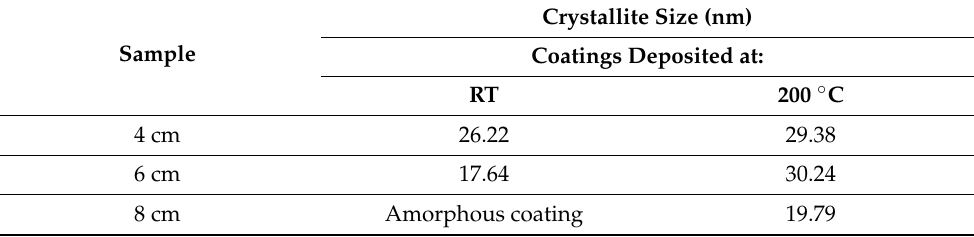
Figure 5. XRD patterns of hydroxyapatite (HA)/Ag multilayer films deposited at ( a ) room temperature (RT), ( b ) 200 °C and different target–substrate distances. The crystallinity of multilayer films is enhanced with increasing deposition temperature and decreasing target–substrate distance [18]. Reprinted with permission from [18] Elsevier 2019. Table 3. The crystallite size of HA/Ag multilayer films prepared at different substrate temperatures and target–substrate distances [18]. Reprinted with permission from [18] Elsevier 2019.